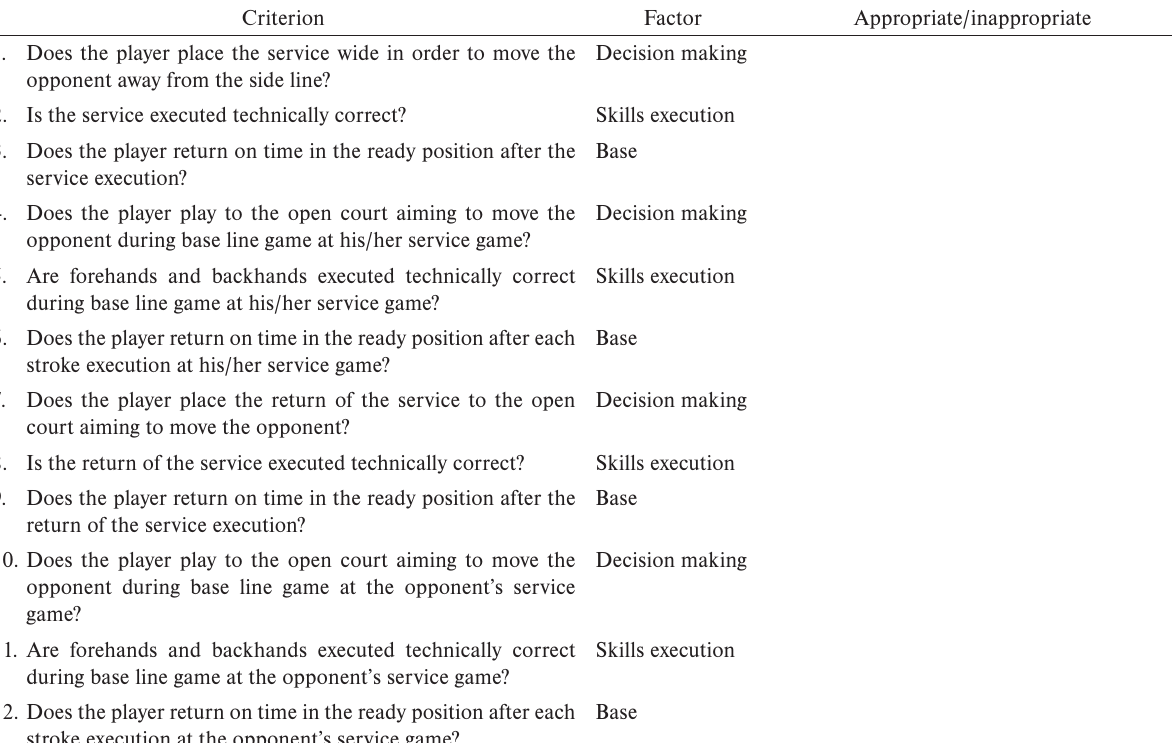
Table 3 Assessment criteria – Game Performance Assessment Instrument